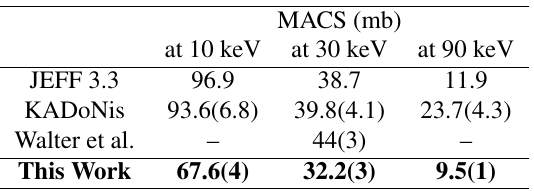
Table 2. Value of the MACS at three di ff erent temperatures. Only statistical uncertainties are included in these